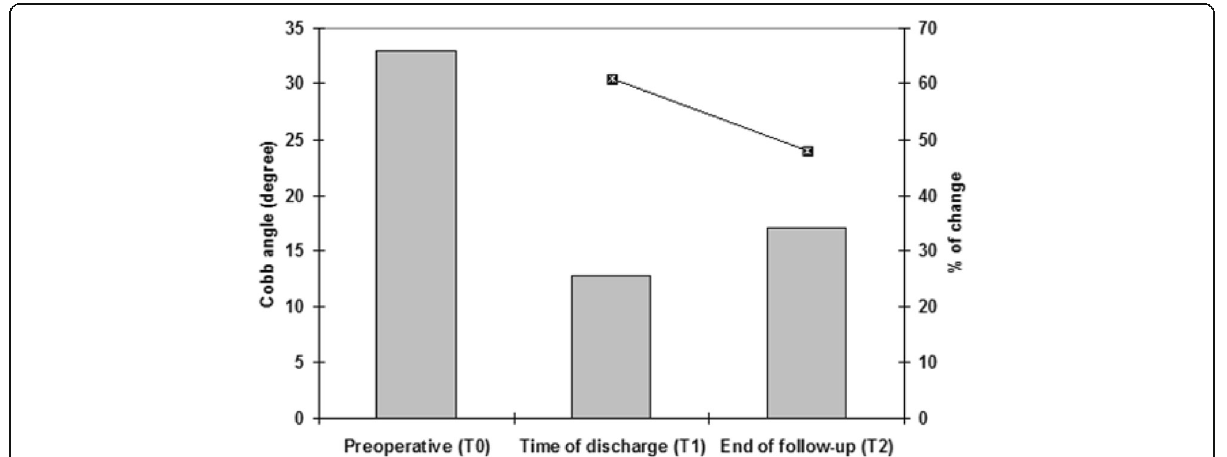
Fig. 1 Kyphosis angle estimated radiologically at time of discharge and at the end of follow-up compared to preoperative angle